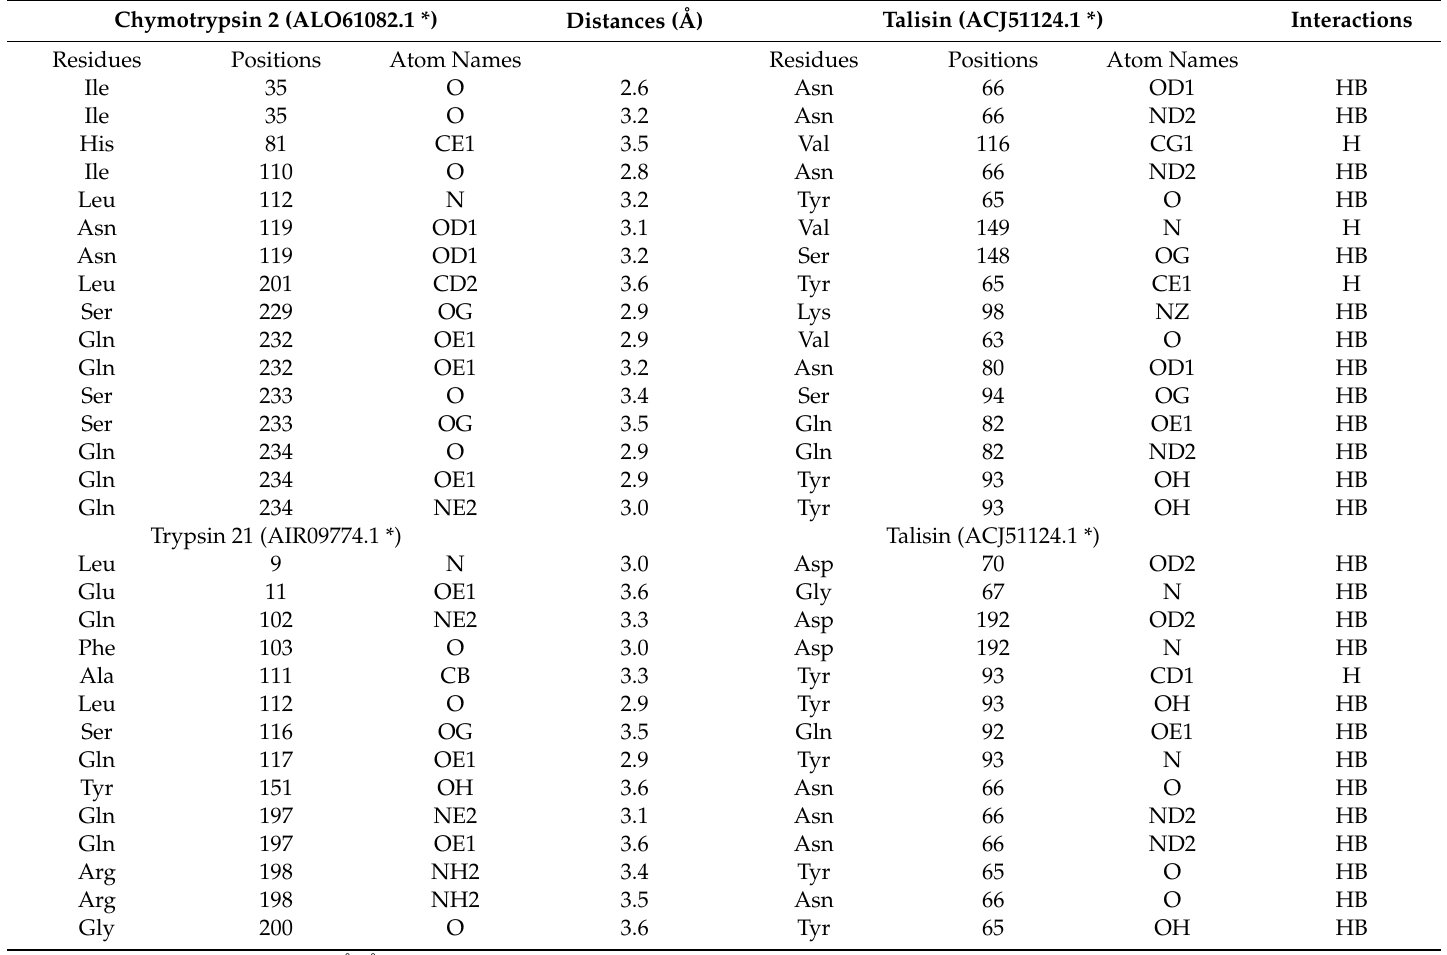
Table 5. In silico interactions for the complexes talisin / Chymotrypsin 2 ( − 11.2 kcal · mol − 1 ) and talisin / Chymotrypsin 12 ( − 10.0 kcal · mol − 1 ). Chymotrypsin 2 (ALO61082.1 *) Distances (Å) Talisin (ACJ51124.1 *) Interactions Residues Positions Atom Names Residues